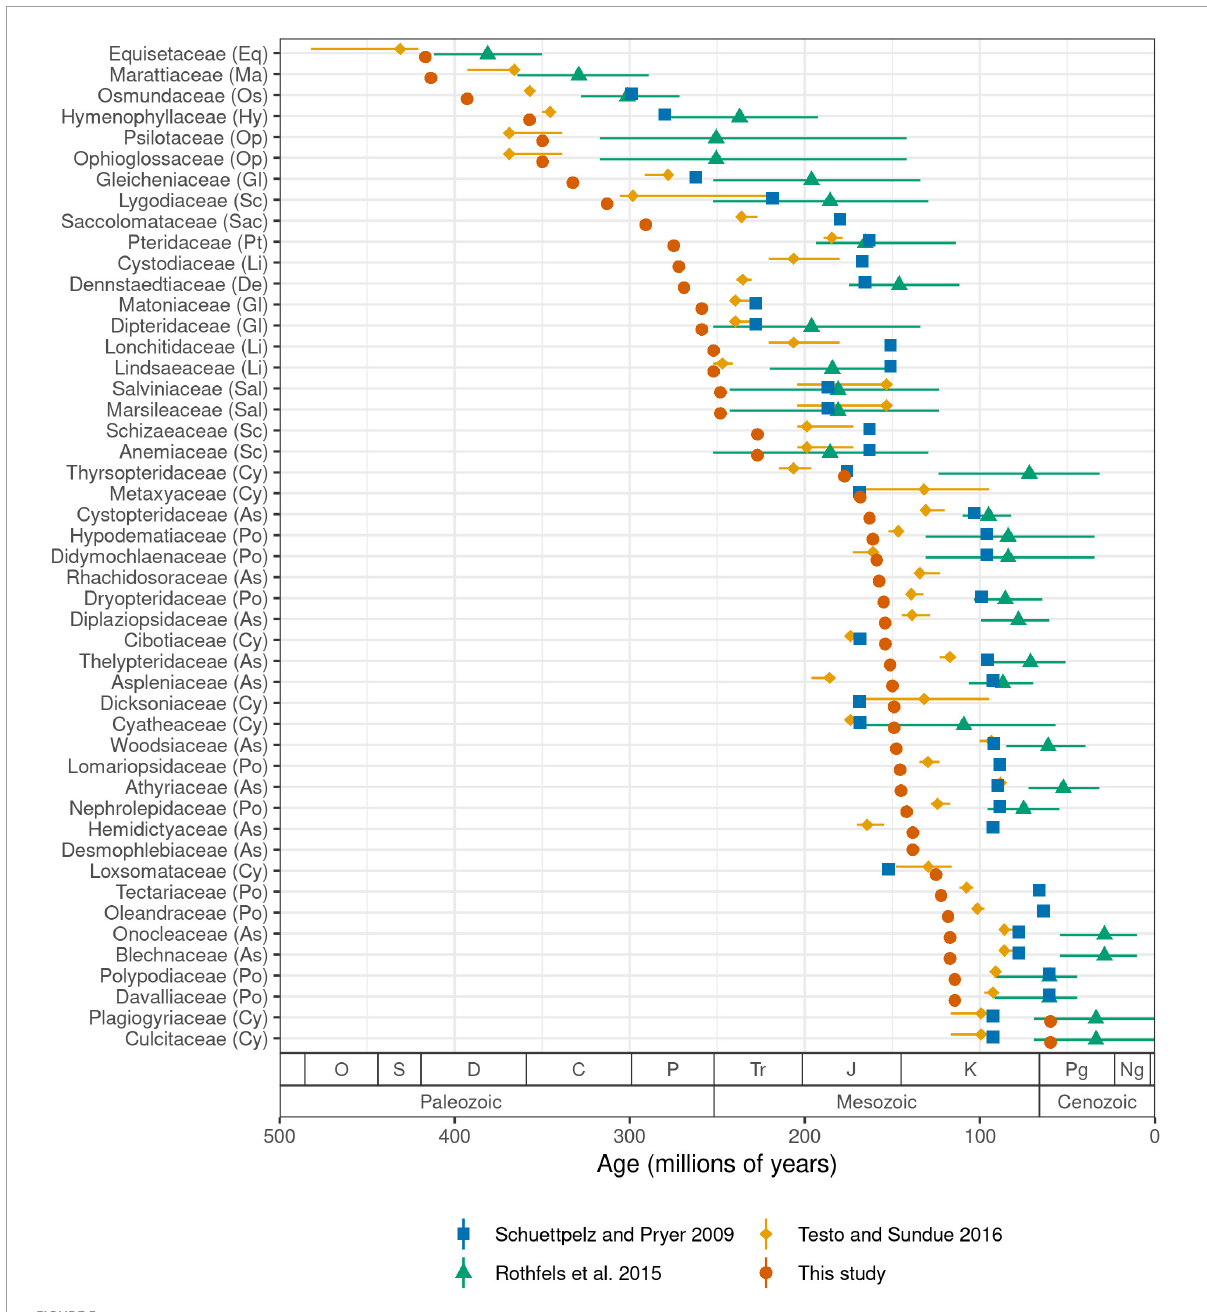
FIGURE5 Stem age of fern families (Ma) estimated by selected studies. For studies that used methods with confidence intervals, error bars indicate lower and upper 95% highest posterior density levels and point indicates median (Rothfels et al., 2015; Testo and Sundue, 2016). For other studies, point indicates best (most likely) estimate (Schuettpelz and Pryer, 2009; this study). Codes in parentheses after family names indicate major clade as in Figure 3 . Period name abbreviations as follows: O (Ordovician), S (Silurian), D (Devonian), C (Carboniferous), P (Permian), Tr (Triassic), J (Jurassic), K (Cretaceous), Pg (Paleogene), Ng